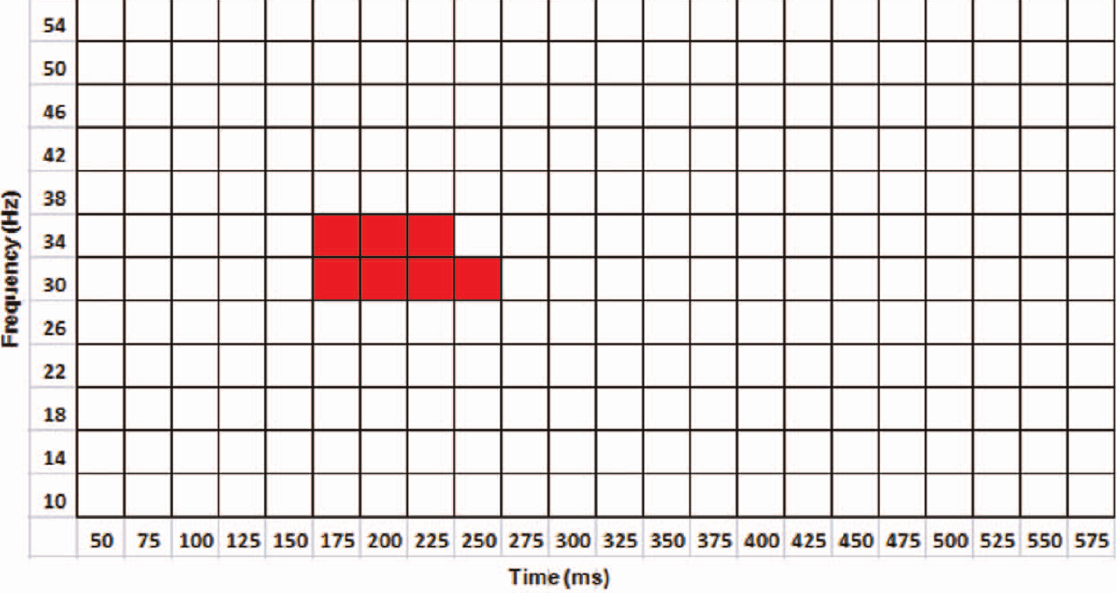
Figure 4. PLV regressions for reduced data set. Each red square indicates a significant positive slope (hFDR corrected, 5% hFDR bound) for PLV as a function of arity from the mean of F3-P3, Fz-Pz, and F4-P4 electrode pairs for the indicated frequency-time band.